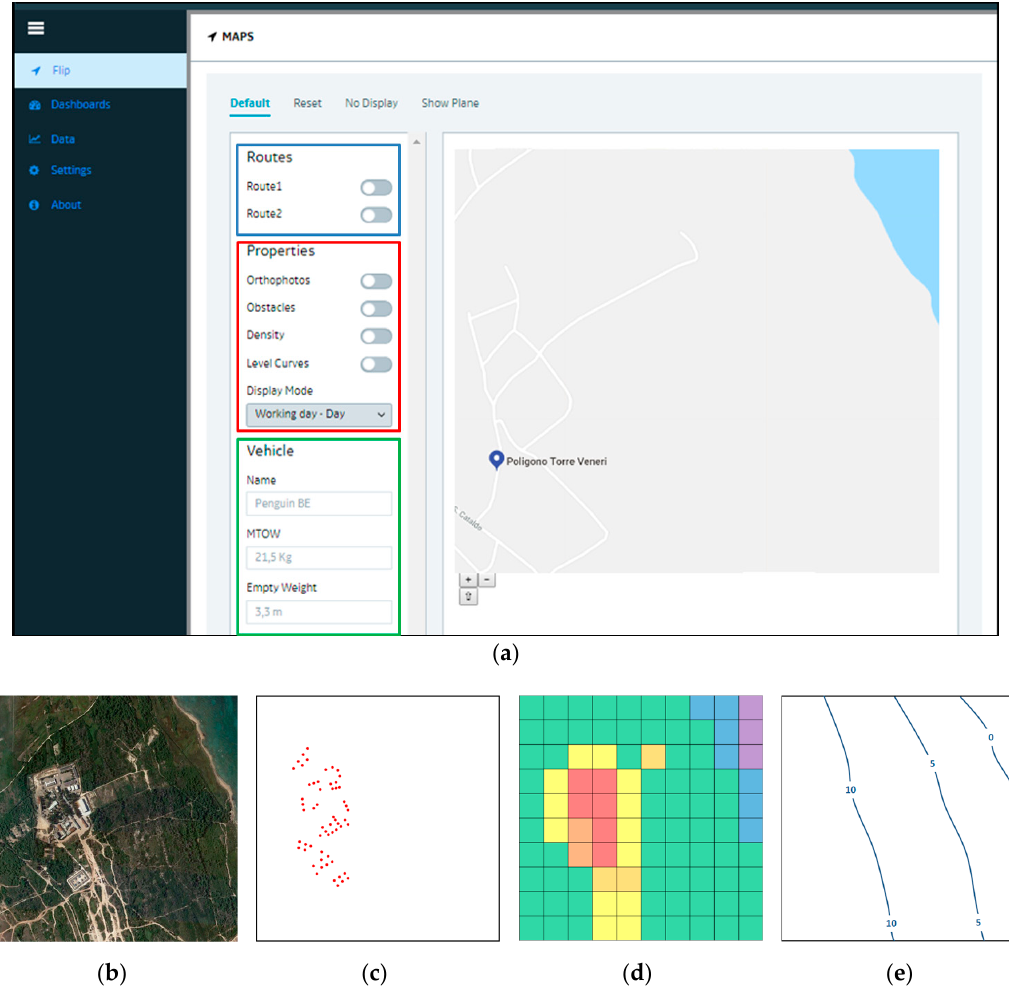
Figure 3. FLIP dashboards: ( a ) Map view, ( b ) orthophoto view, ( c ) obstacles view, ( d ) population density view, ( e ) Isolevel curves view.